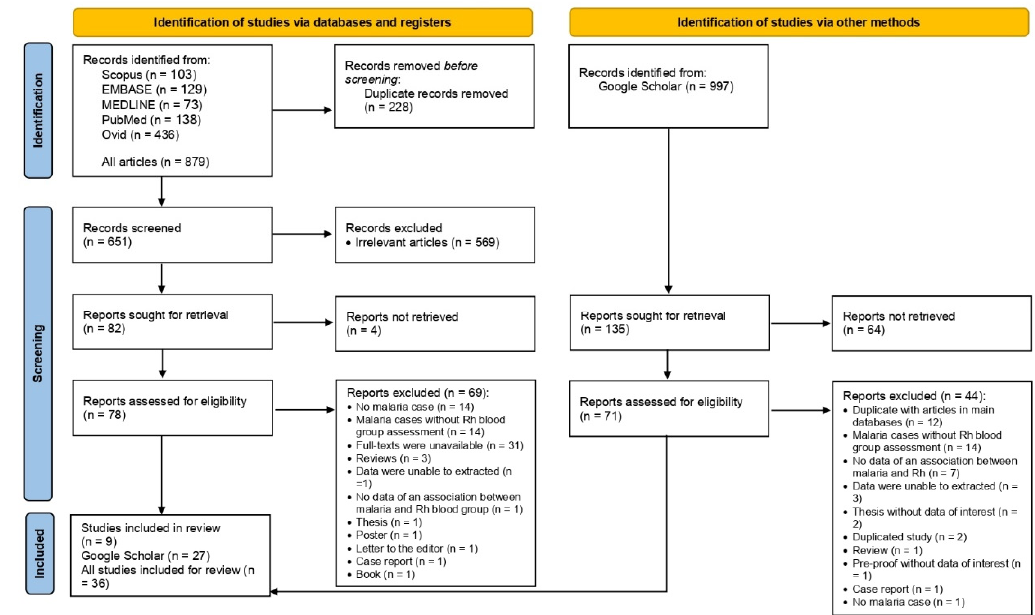
Figure 1. Flow diagram of study selection.